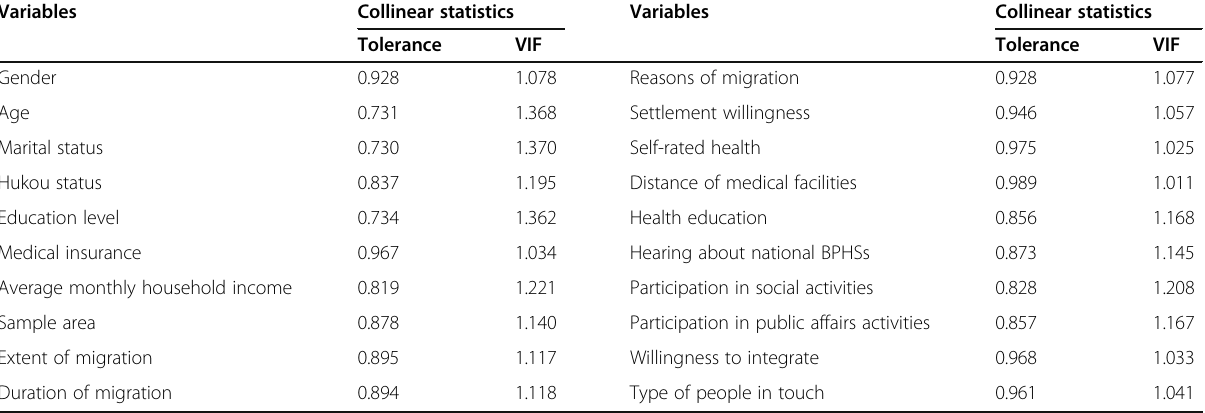
Table 5 Co-linearity analysis of factors that associated with health records establishment of young Chinese migrants